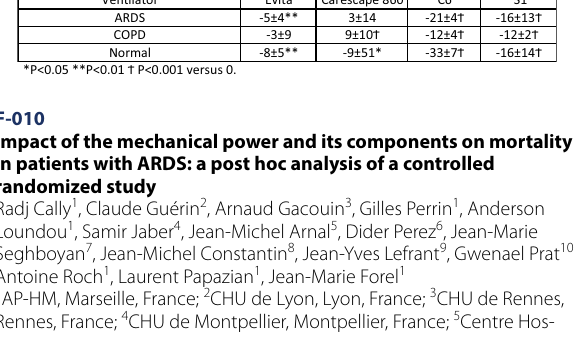
Table 1 Change in tidal volume between no (Automatic tube com‑ pensation) ATC and ATC plus tube Table1. Ventilator Evita